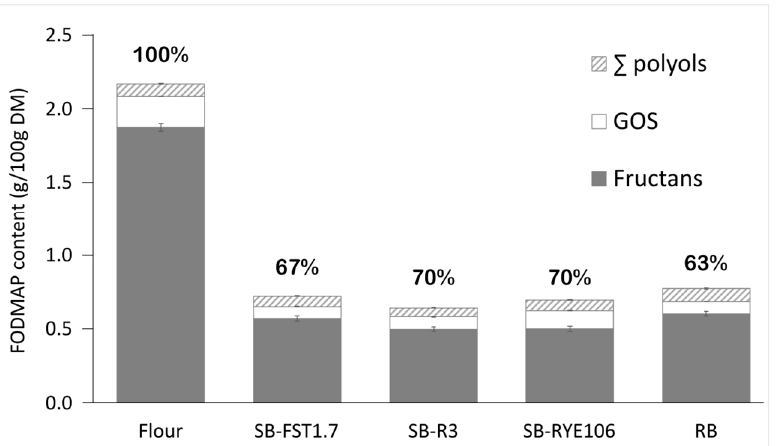
Figure 5. Total FODMAP (fermentable oligo-, di-, and mono-saccharides and polyols) concentration (g/100 g DM) in whole-wheat flour, RB produced with commercial baker’s yeast preparation (2%; Puratos, Belgium) and with baker’s yeast and sourdough (20%) based on homofermentative fermen- tation by Lactiplantibacillus plantarum FST1.7 (SB-FST1.7), Lacticaseibacillus paracasei R3 (SB-R3), and Pediococcus pentosaceus RYE106 (SB-RYE106). The solid colour indicates fructans; no fill—GOS (raffi- nose + melibiose); diagonal straps—polyols (sorbitol + mannitol). No fructose in excess of glucose was detected. Values above the columns represent the degradation of total FODMAPs compared to the fl our (%).